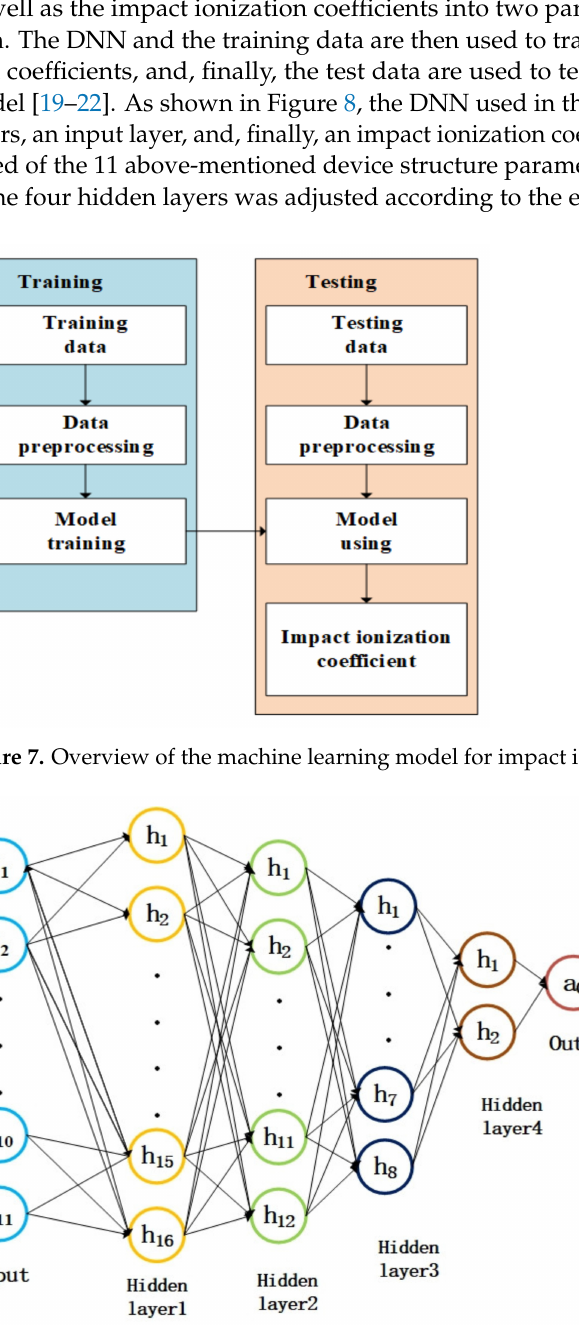
Figure 8. Backpropagation DNN architecture for impact ionization coefficient